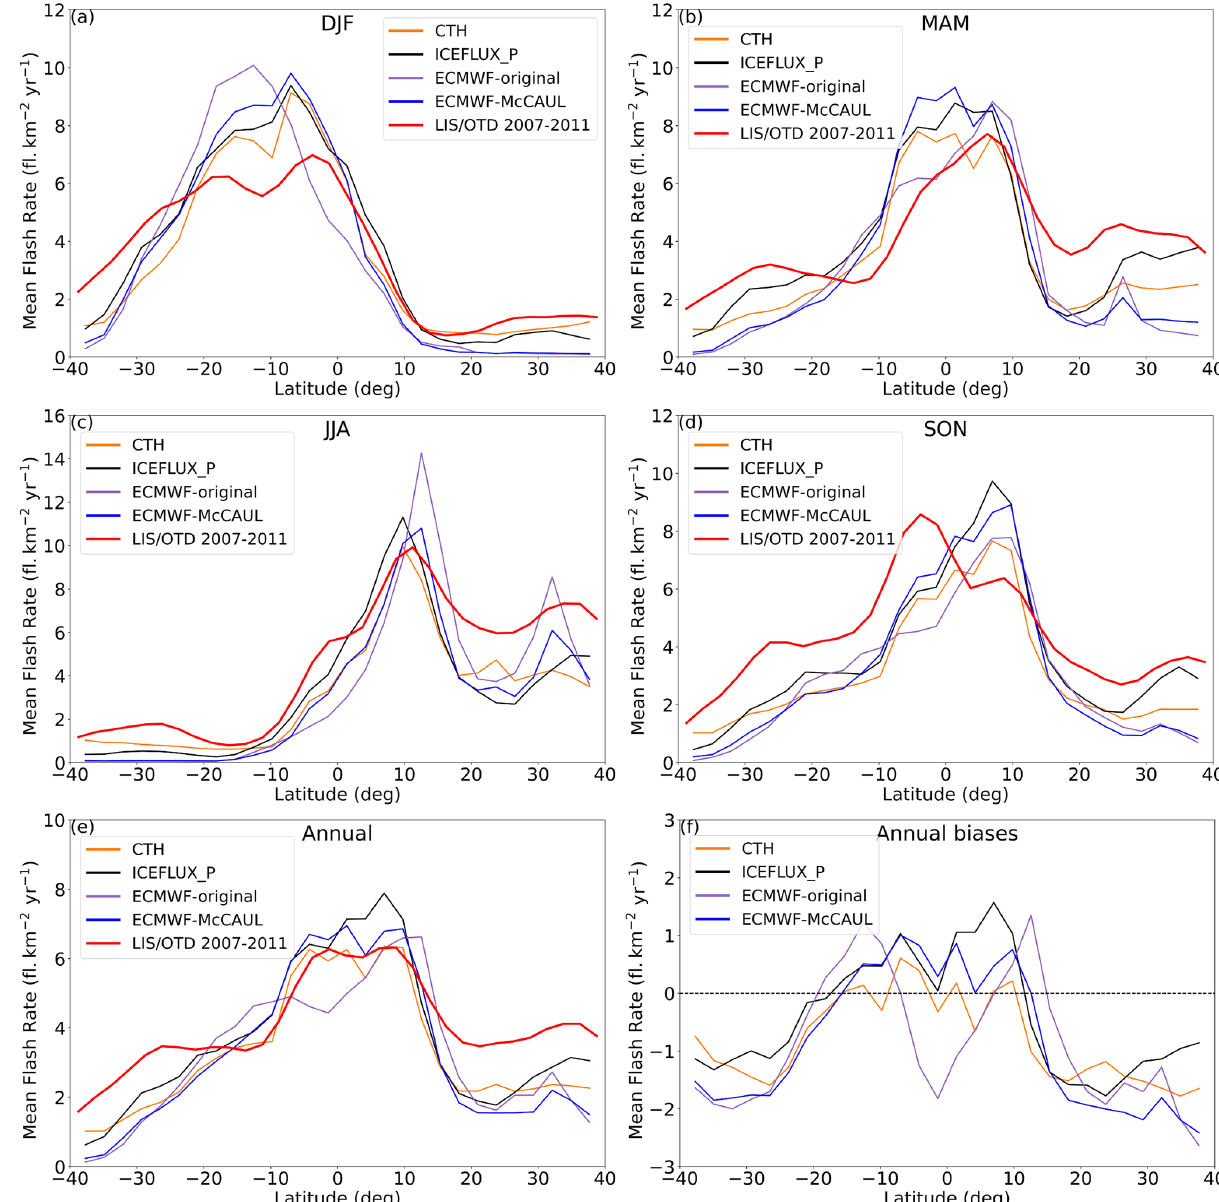
Figure 6. Seasonal and annual zonal average lightning flash density distribution from the LIS 2007–2011 climatology (red line) and from the simulation results (2007–2011) obtained using different lightning schemes. The biases (model-obs.) in panel (e) are also presented in panel (f)